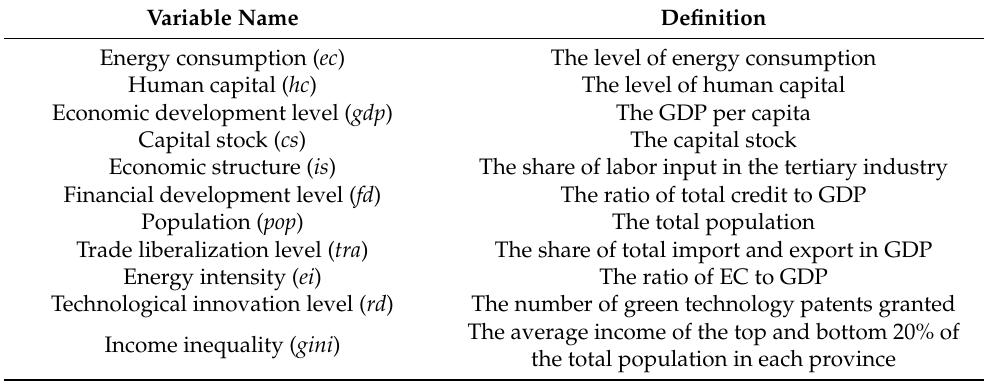
Table 1. Definition of